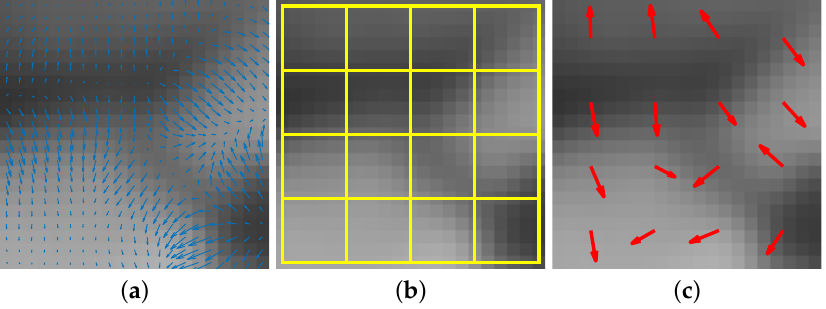
Figure 5. Divided sub-patches and the main gradients: ( a ) a local gradient field; ( b ) divided sub-patches; ( c ) main gradients computed by